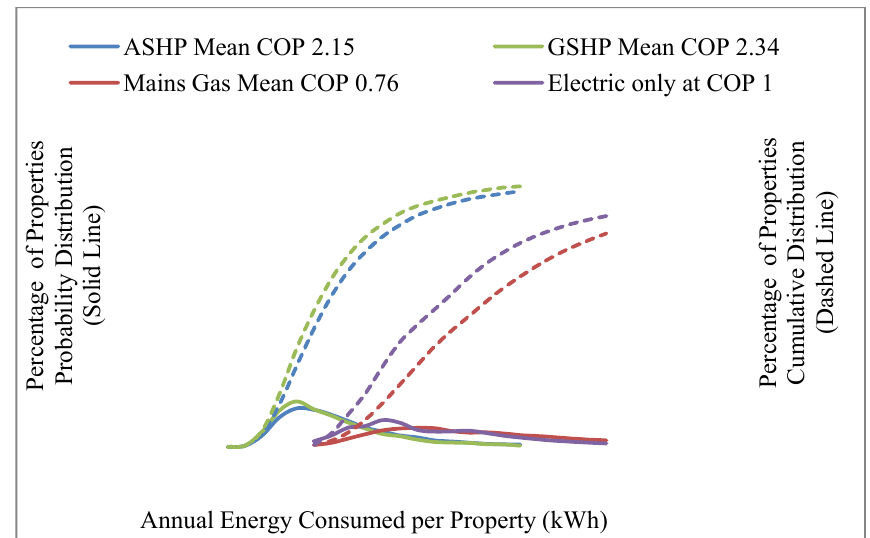
Figure 4. Annual energy consumption per property.